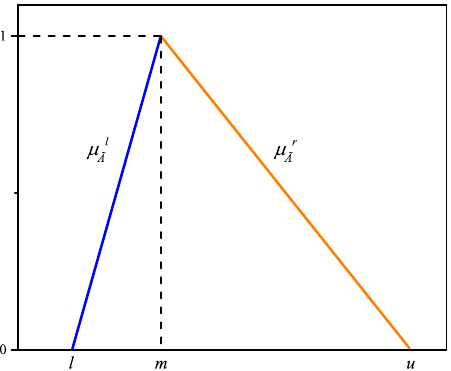
Figure 2. The representation of a triangular membership function.